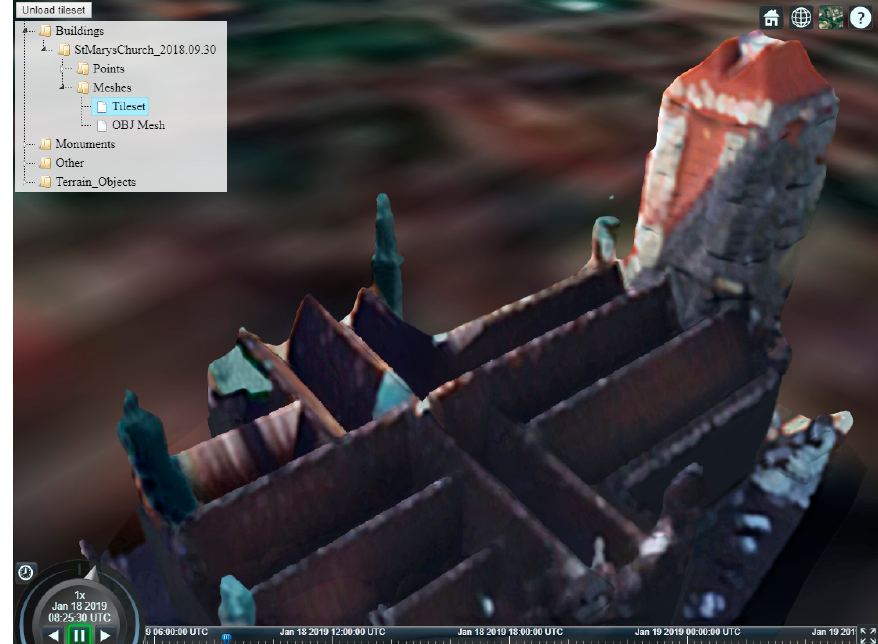
Figure 4. The system's Web-based Geographic Information System (Web-GIS) client displaying a model reconstructed from the processed dataset.